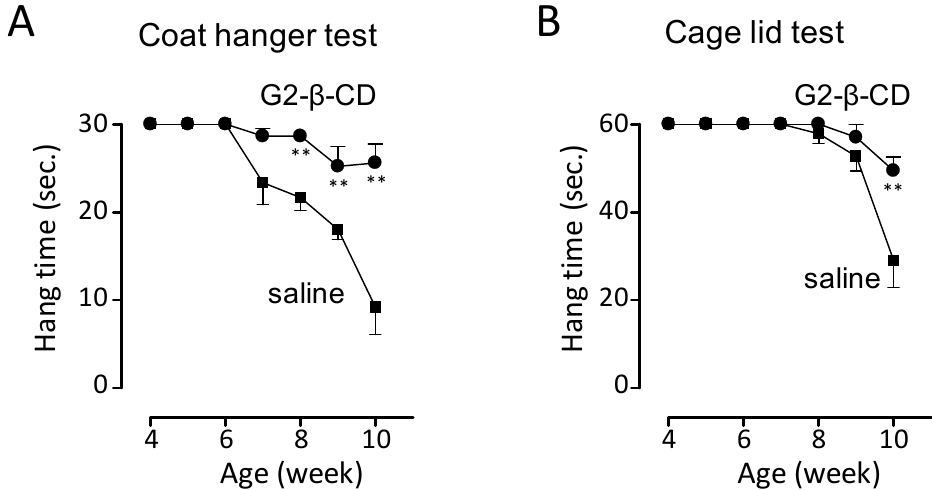
Figure 8. Effect of the intracerebroventricular injection of G2- β -CD on motor function in Npc1 − / − mice. An injection of G2- β -CD (21.4 μ mol/kg) was performed in mice at 4 weeks of age and motor function was evaluated every week up to 10 weeks. Results of the hanging time in the coat hanger test ( A ) and cage lid test ( B ). Each point represents the mean ± S.E.M ( n = 6). ** P < 0.01 compared with the saline group.